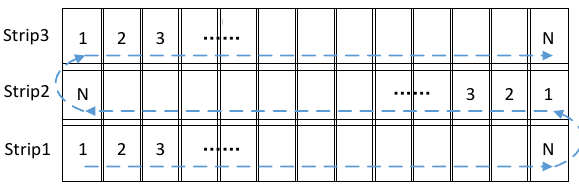
Figure 4. Working principle of the imaging system. The timing/velocity relationships between the gimbal and the FSM, and the timing diagram of the exposure trigger signal during imaging is shown in Figure 5. The gimbal rotates continuously at a constant angular velocity during the work. Within one frame of imaging time, the FSM takes T1 time to accelerate to the compensation angular velocity, calculated by the command unit, to maintain stabilization. Then, the command system controls the detector exposure in T2 period. After one exposure, the FSM will return to the initial position within T3 time to prepare for the next exposure. Although FSM accelerates in both TI and T3 period, the T1 time is generally longer as the FSM has to reach a stable speed before the exposure. The acceleration of the FSM is greater during the T3 period. As the exposure time of infrared detector is longer (up to 20 ms) than the visible light detector, the T1 and T3 time of the infrared subsystem is shorter than the visible light subsystem when the imaging frame frequency is constant. So the requirement for the acceleration performance of the FSM in the infrared subsystem is higher.